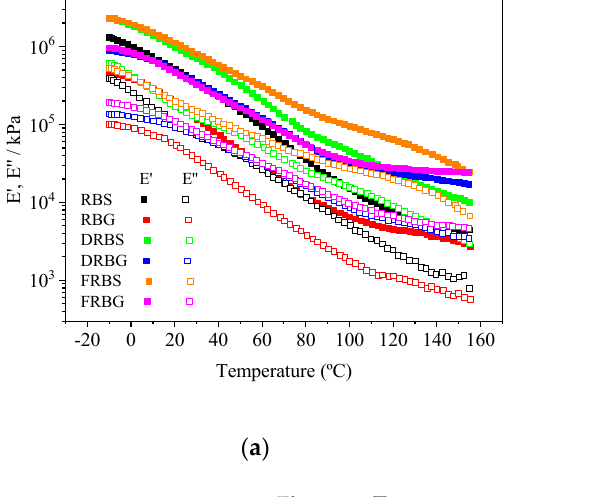
Figure 2. Temperature sweep tests between − 10 and 160 ° C performed on the different evaluated systems at 1 Hz; ( a) Elastic (E ′ ) and viscous (E ″ ) modulus ( b ) Loss tangent (tan δ ).